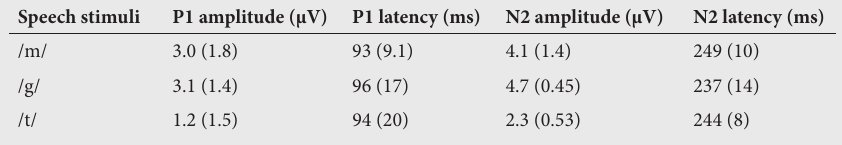
Table 3. Mean peak amplitudes, latencies and standard deviations for P1 and N2 for the 8 - 12-year age group, in response to the three speech sounds /m/, /g/, /t/